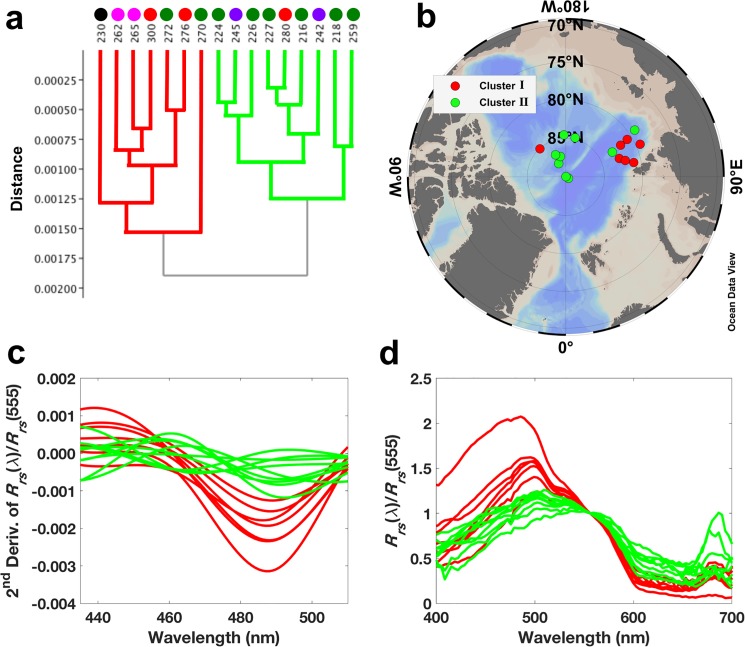
Hyperspectral AOP clustering.(a) Dendogram (cophenetic correlation coefficient: c = 0.87) for sampling stations based on hierarchical cluster analysis applied to the 2nd derivative of Rrs(λ)/Rrs(555) (following Torrecilla et al., 2011). (b) ODV map [44] showing the position of each station according to the classification based on the hierarchical clustering. (c) 2nd derivative of normalized hyperspectral remote sensing reflectance, Rrs(λ)/Rrs(555), with respect to the wavelength range of 435–510 nm (following Torrecilla et al. [65]). (d) Normalized hyperspectral remote sensing reflectance, Rrs(λ)/Rrs(555) in the visible wavelength range. Colored circles in (a) refer to the environmental clusters presented in Fig 4. Colors in (c) and (d) are in accordance with the clusters presented in (a) and (b).